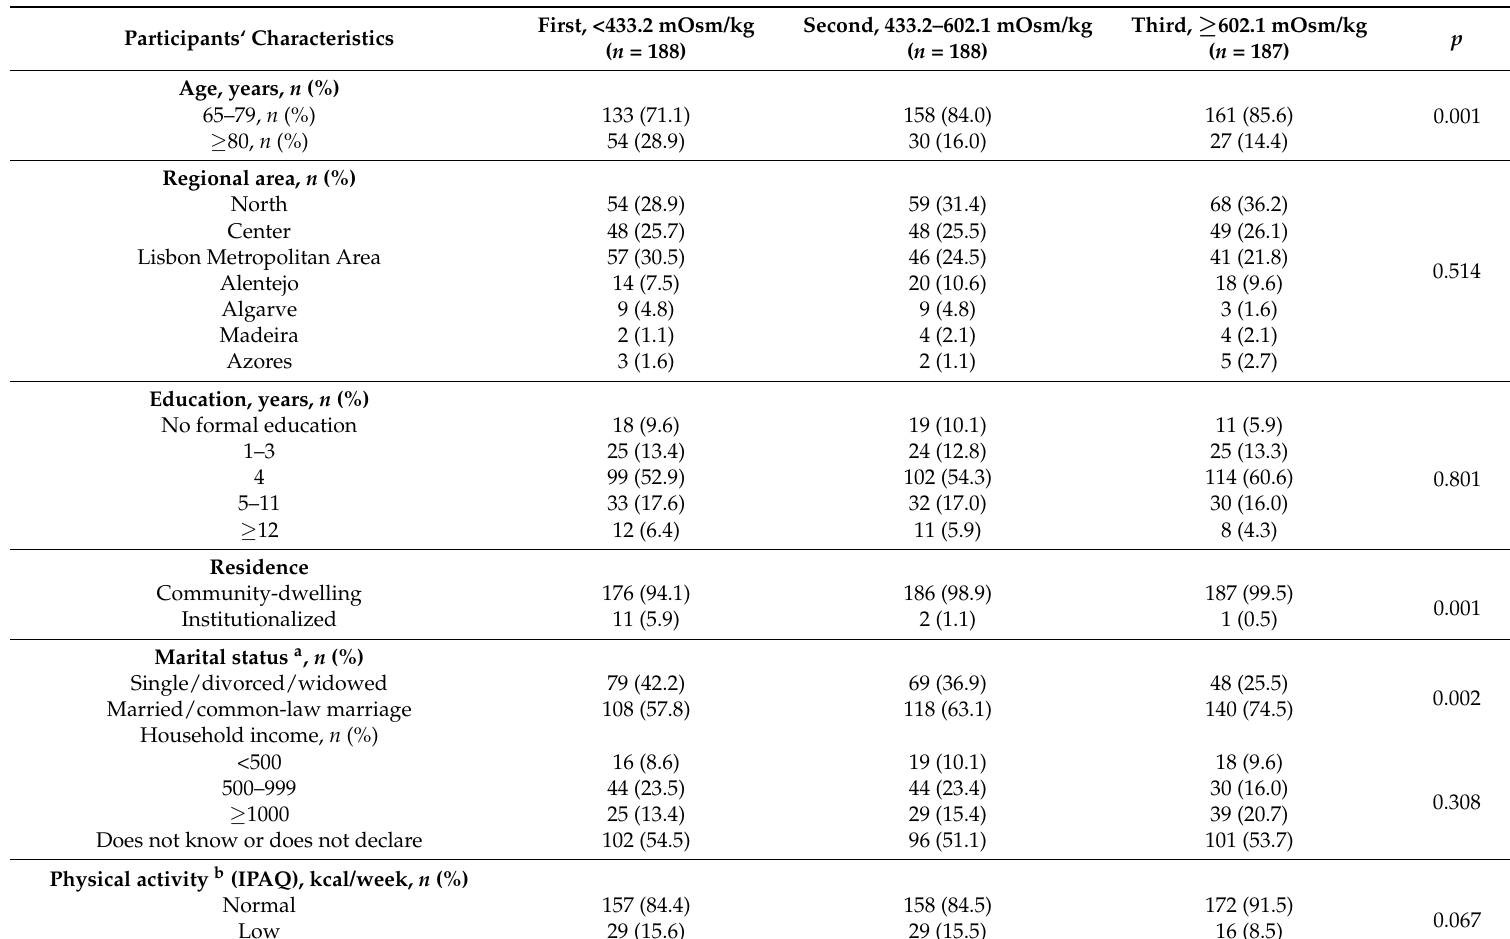
Table 2. Socio-demographic, lifestyle, clinical, anthropometric and nutritional characteristics of 563 older Portuguese men, ≥ 65 years old, participating in a cross-sectional observational study according to osmolality (mOsm/kg)